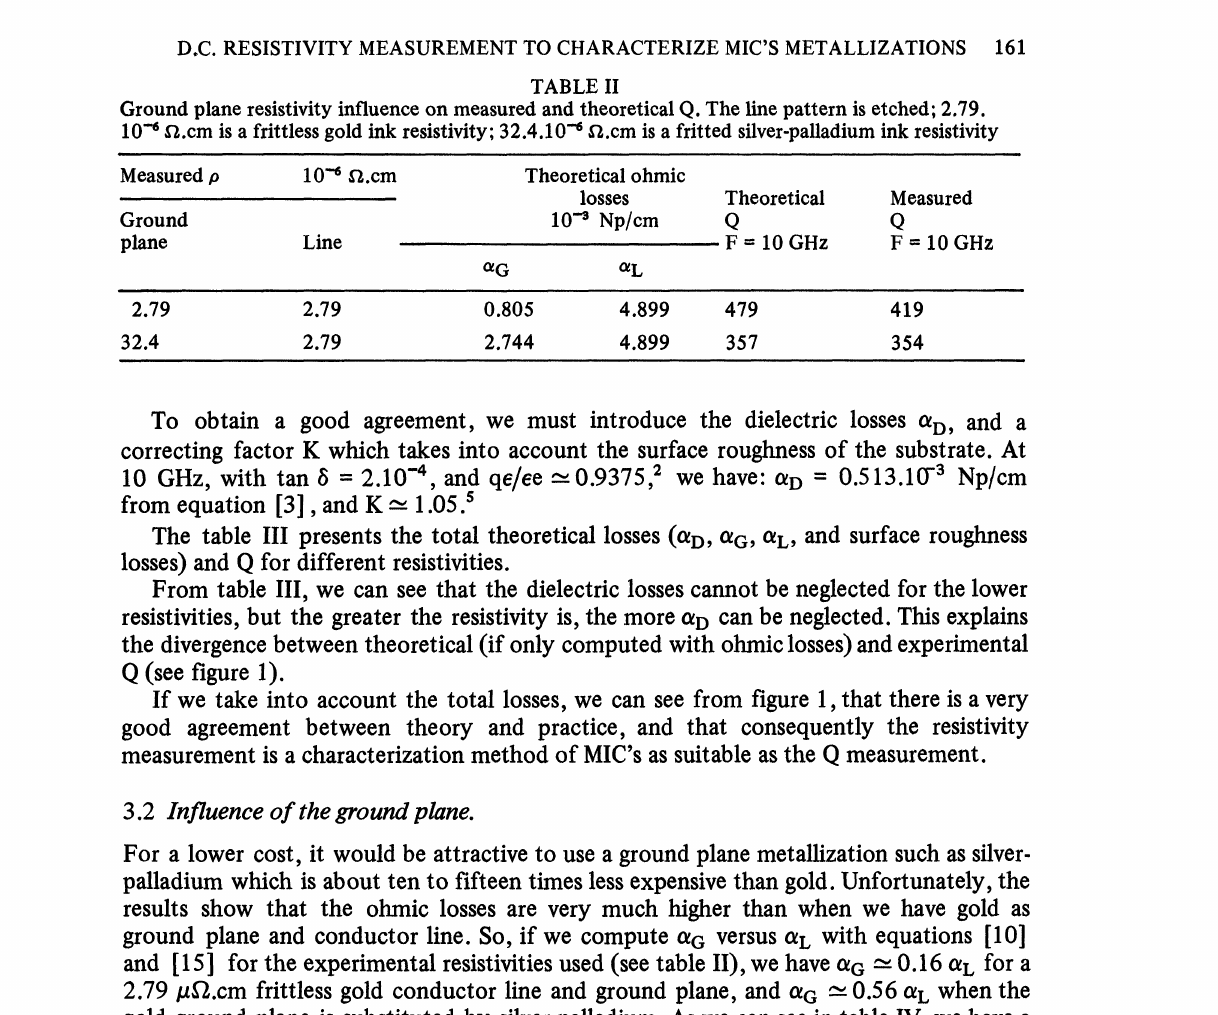
TABLE IIl Total theoretical losses and Q for some